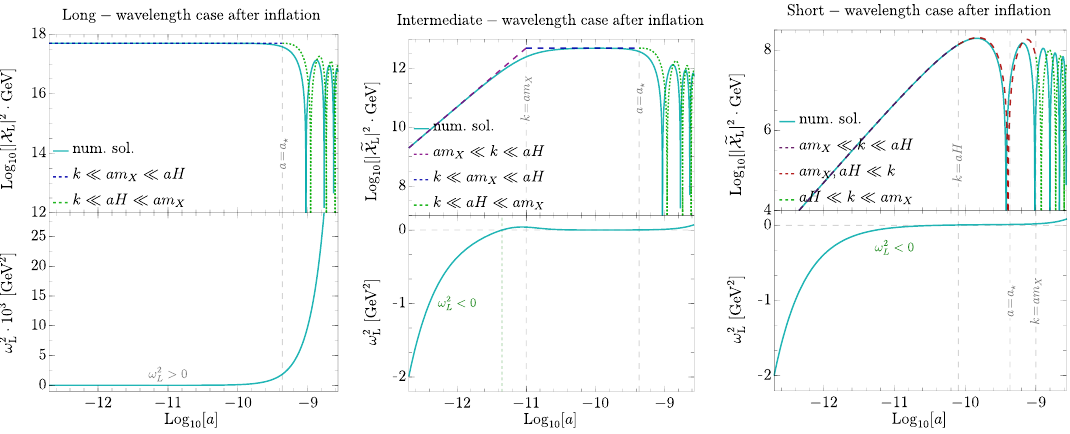
(lower) with the scale L